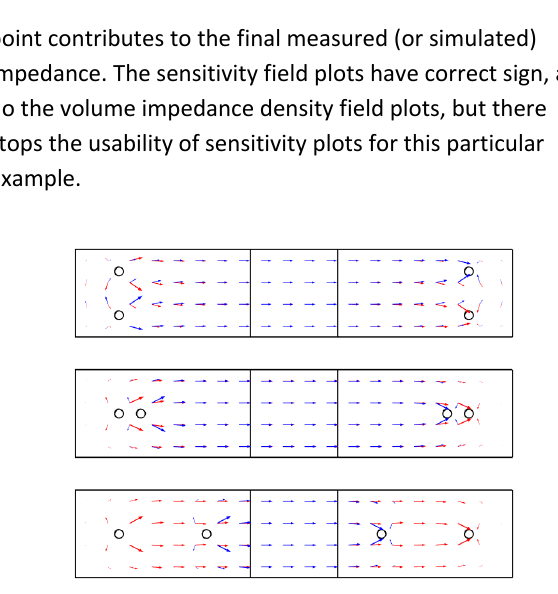
Fig.1: Current density vector plots for the three models, starting with model A at the top followed by model B and C. The red vectors are CC current densities and the blue vectors are reciprocal current densities.